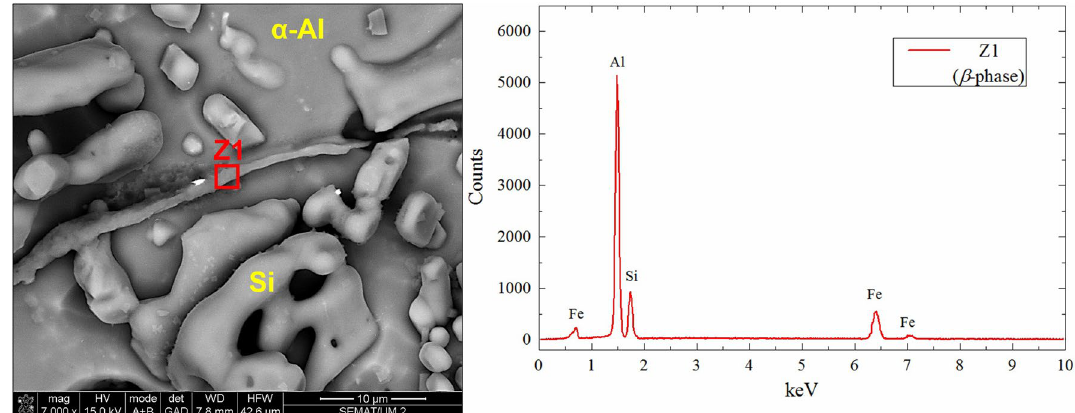
Figure 9. SEM (Secondary electron) image and EDS profile the location of which is indicated by the red box for a deeply etched sample.